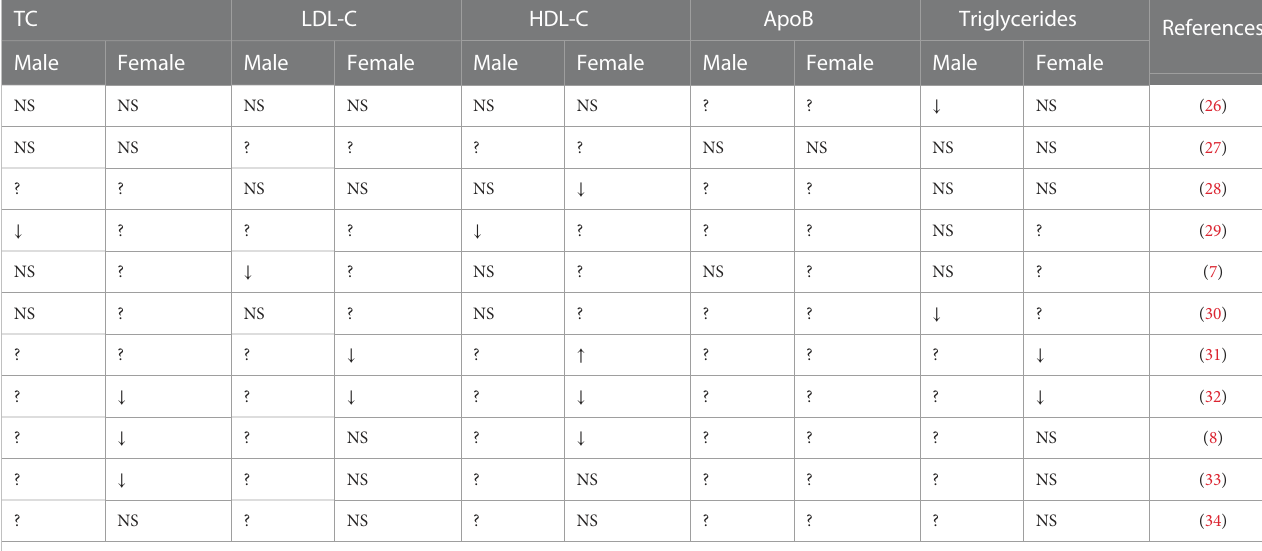
TABLE 2 Randomized controlled trials of DHEA or DHEAS supplementation in males and females. TC LDL-C HDL-C ApoB